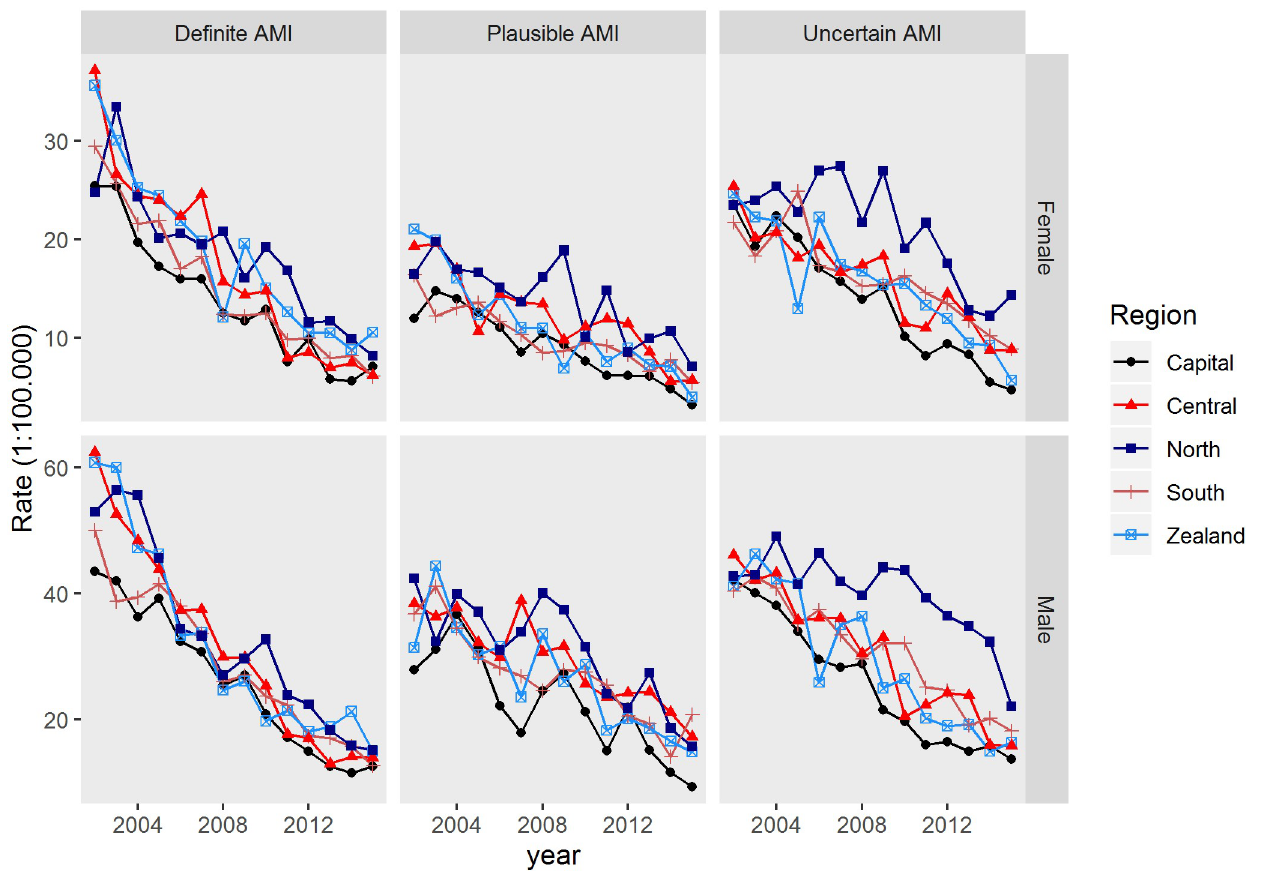
Fig 1. Age-standardised mortality rates from acute myocardial infarction by region and diagnostic support. Age-standardised mortality rates from acute myocardial infarction (AMI) per 100,000 population, stratified by gender and by diagnostic support for fatal AMI, for each official Danish region ( N = 36,669).